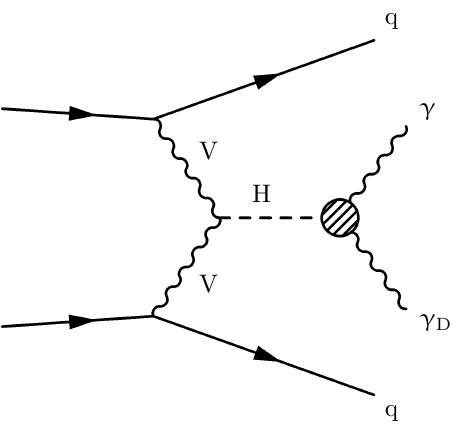
Figure 1 . A Feynman diagram for the VBF production of the qqH( γγ